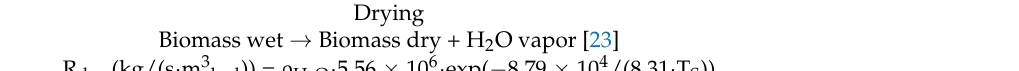
Table 2. Reactions and reaction rates used in the present